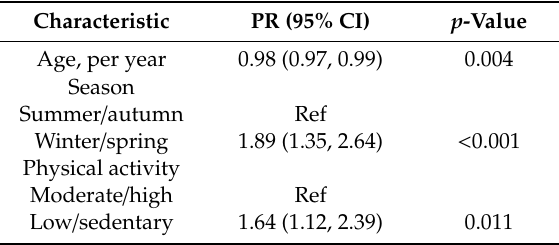
Table 2. Poisson regression model showing predictors of vitamin D deficiency (serum 25-hydroxyvitamin D concentration < 50 nmol / L) in adults aged ≥ 18 years who were born in Africa and were included in the current study ( n =